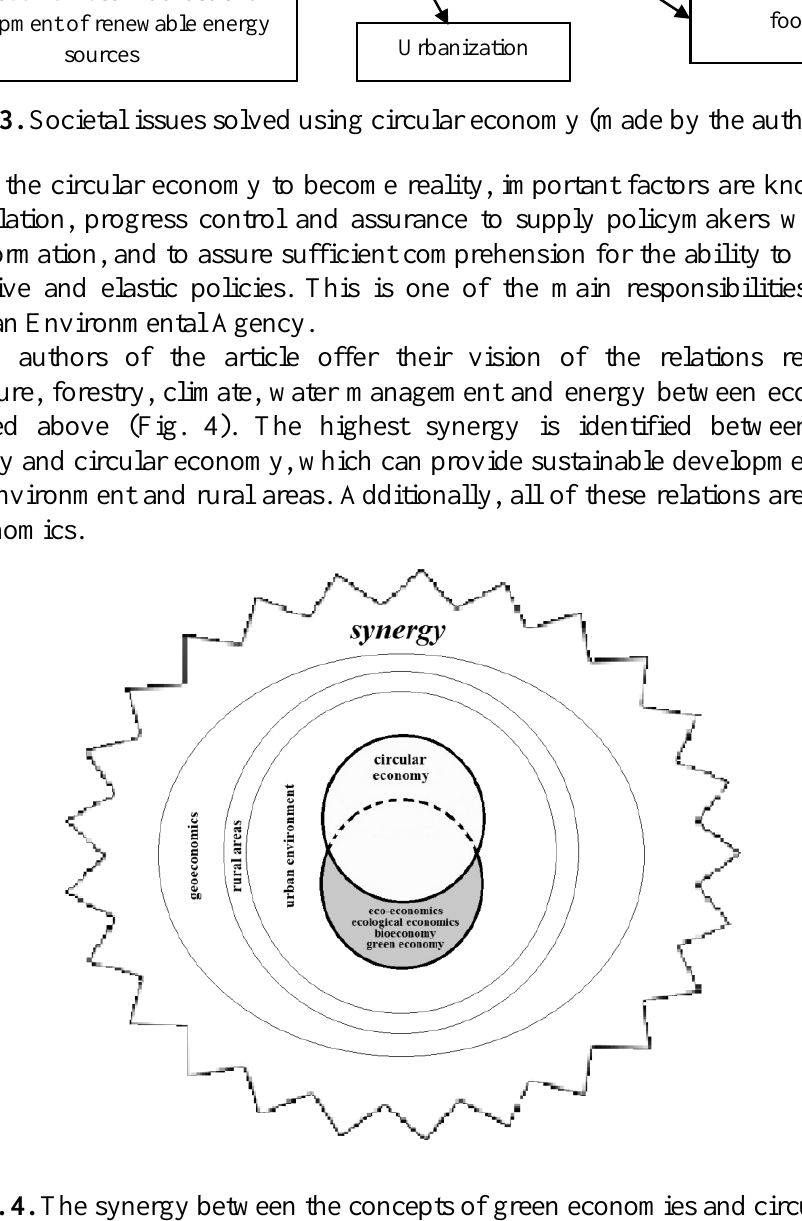
Fig. 4. The synergy between the concepts of green economies and circular economy (made by the